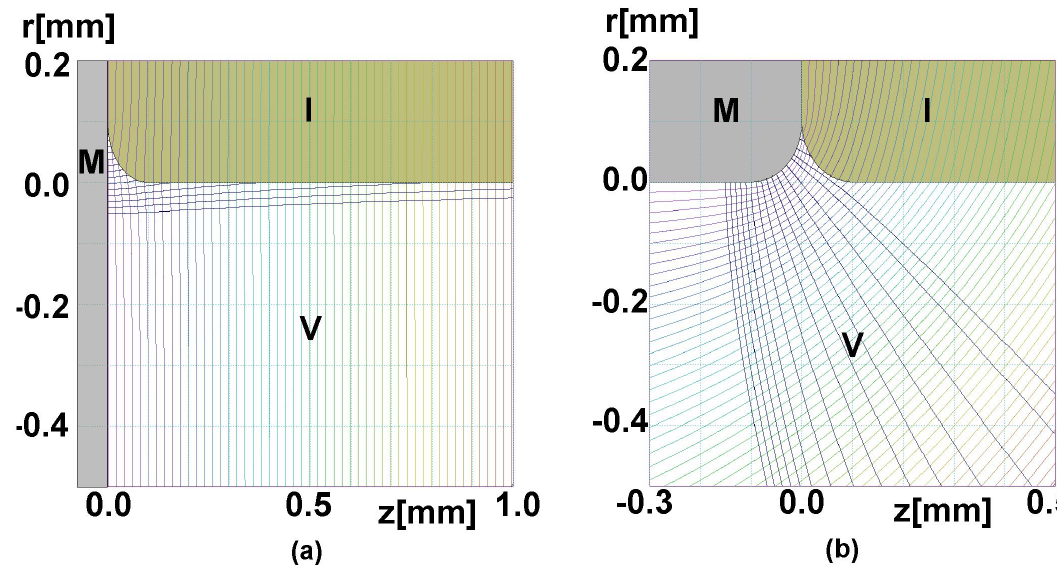
FIG. 20. (Color) Ray traced electrons emitted on the cathode surface near an imperfect triple junction. In (a) an ordinary cathode triple junction is studied whereas in (b) an imperfect flat cathode triple junction of the perfect type seen in Fig. 17(a). The imperfections are introduced by rounding specific corners to a radius of 0.1 mm. All other parameters are the same as in Fig. 17.